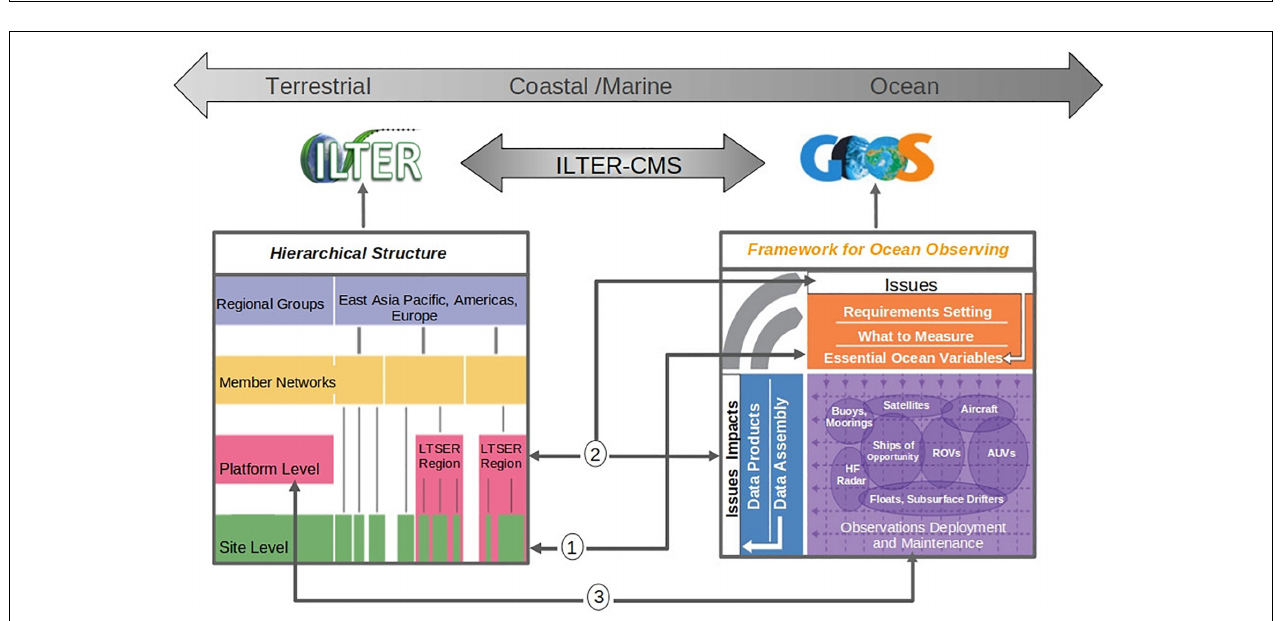
FIGURE 3 | Timeline of the establishment of long-term coastal and marine observation sites and the implementation of the International Long-Term Ecological Research (ILTER) Program.